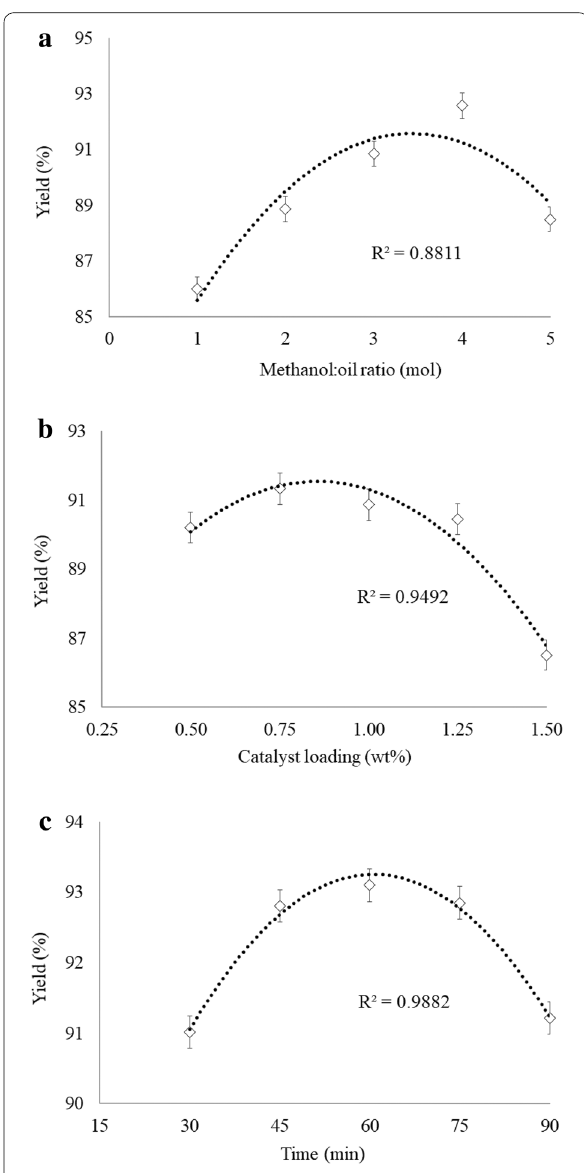
Fig. 4 Biodiesel yield at varied a methanol–oil ratio, b catalyst loading, and c time